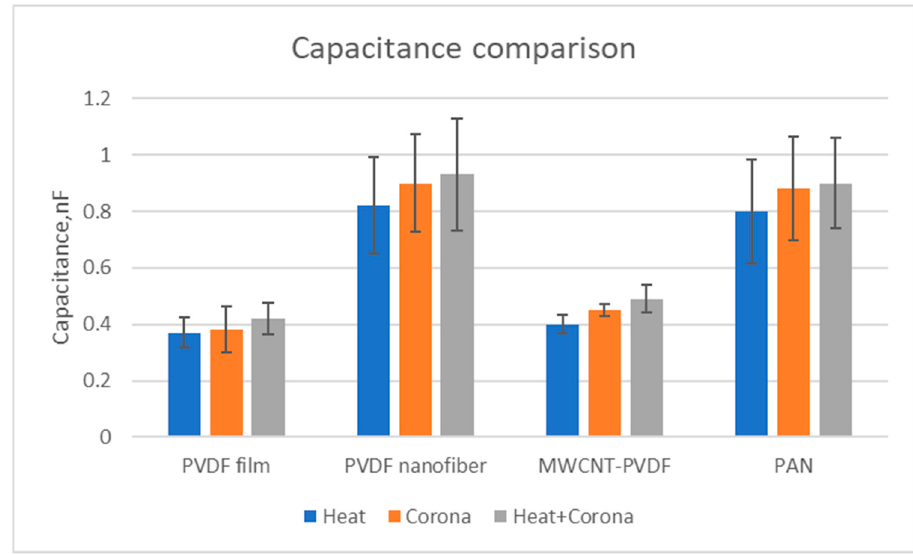
Figure 19. Comparison of capacitance of all nanofiber membrane and films .